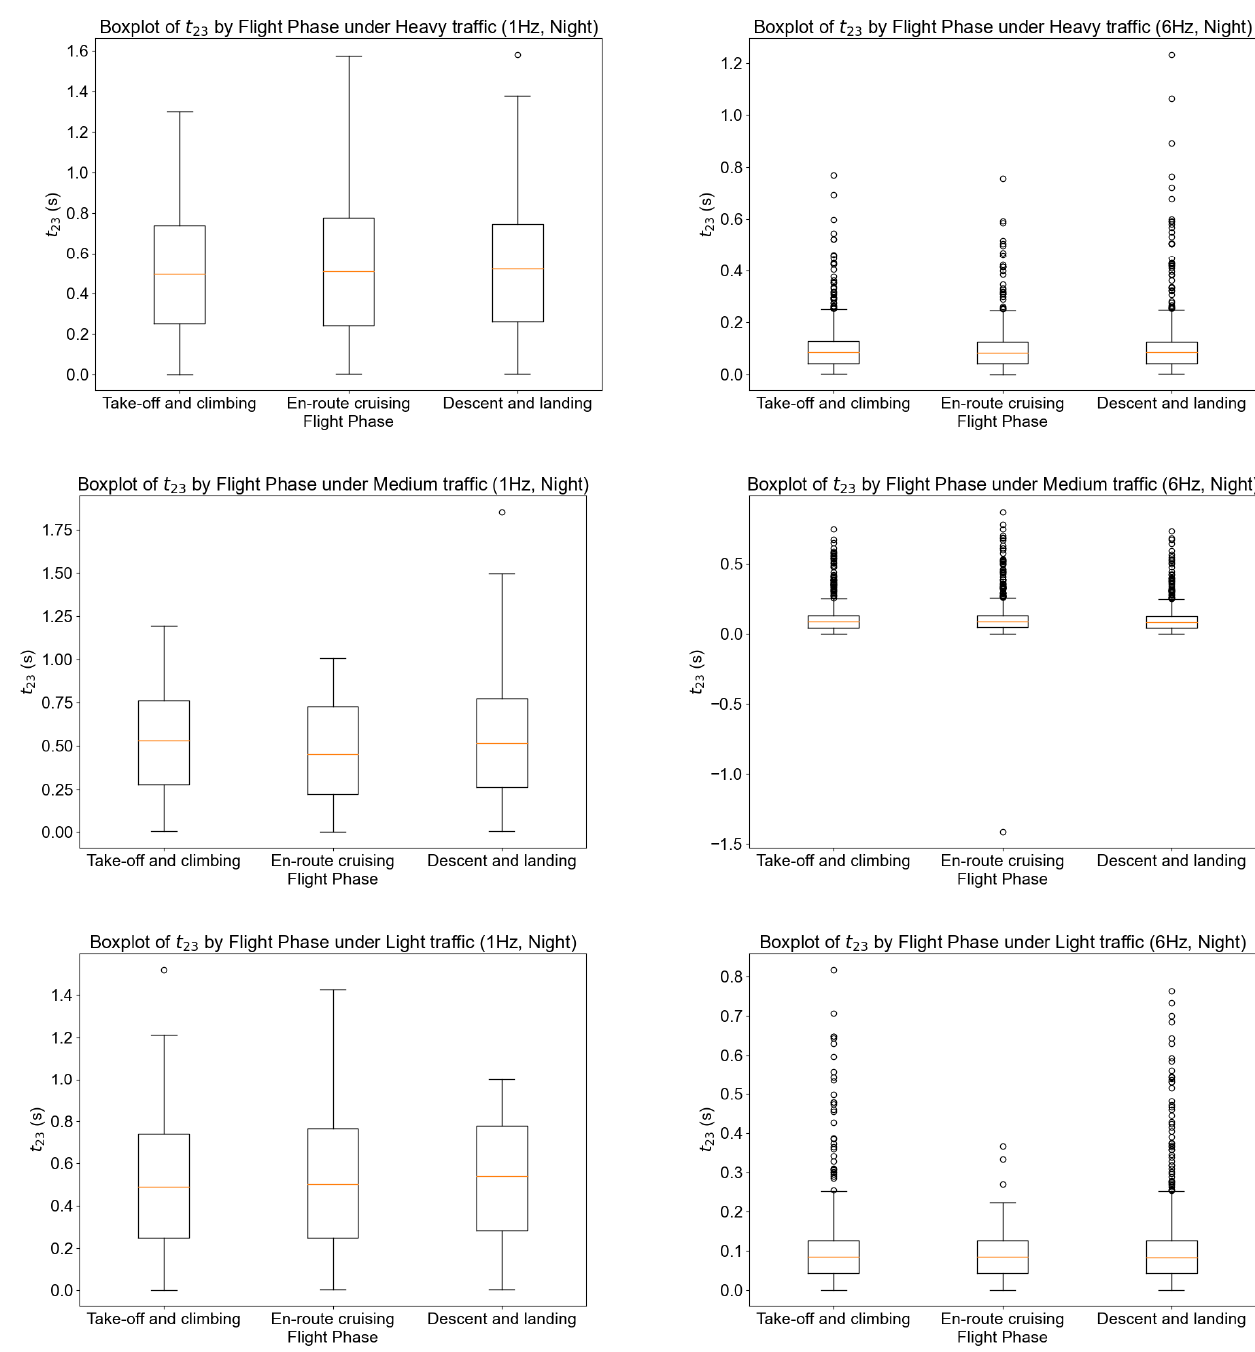
Figure A4. The boxplots of 𝑡 (cid:2870),(cid:2871) during night-time setting.